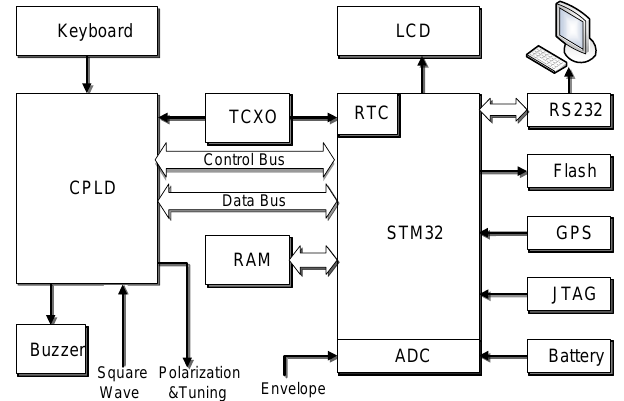
Figure 14. Digital circuit block diagram.